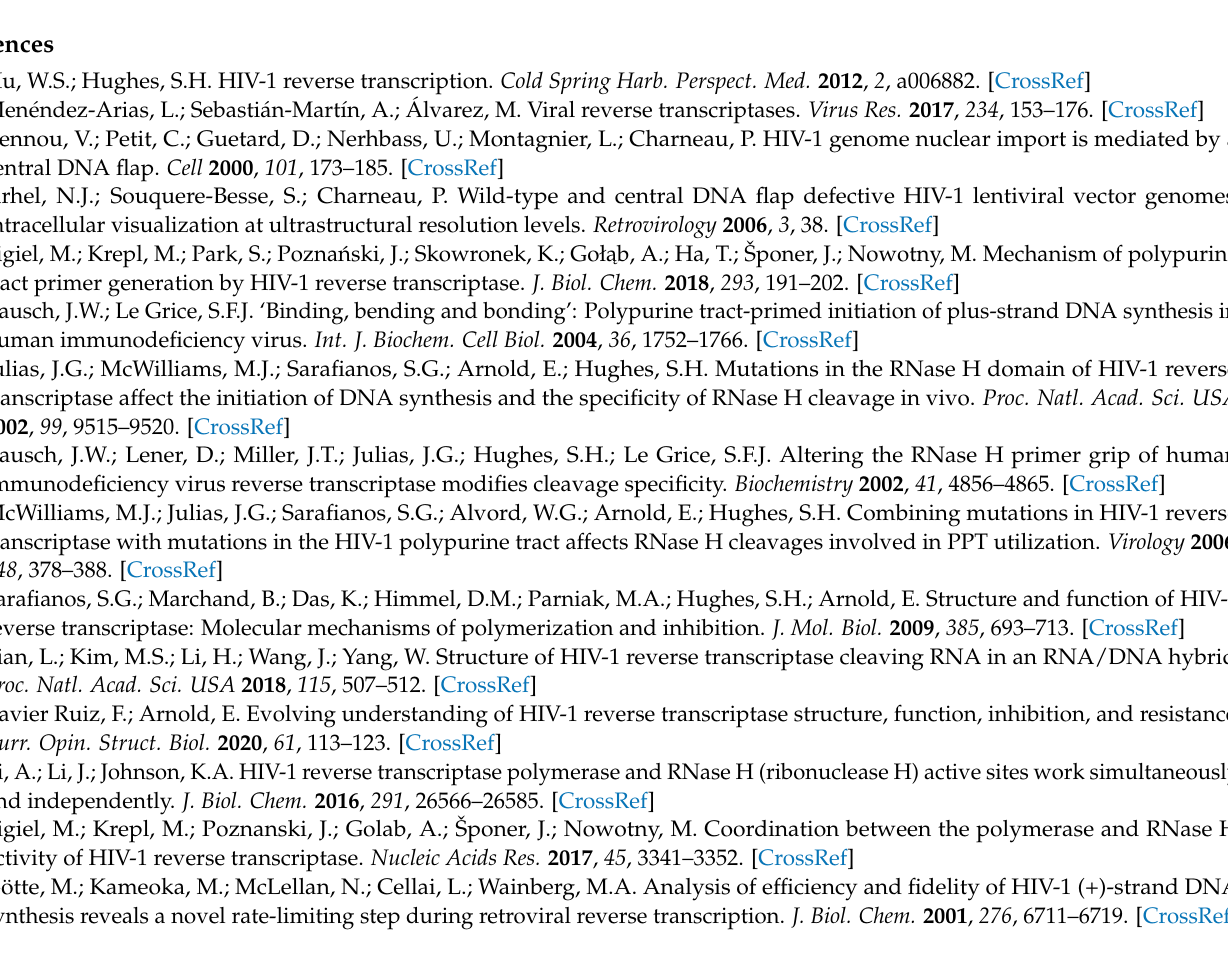
on representative HIV-2 PPTs, Figure S3: Effect of one-amino-acid insertions in the connection subdomain of HIV-2 EHO on the RNase H cleavage